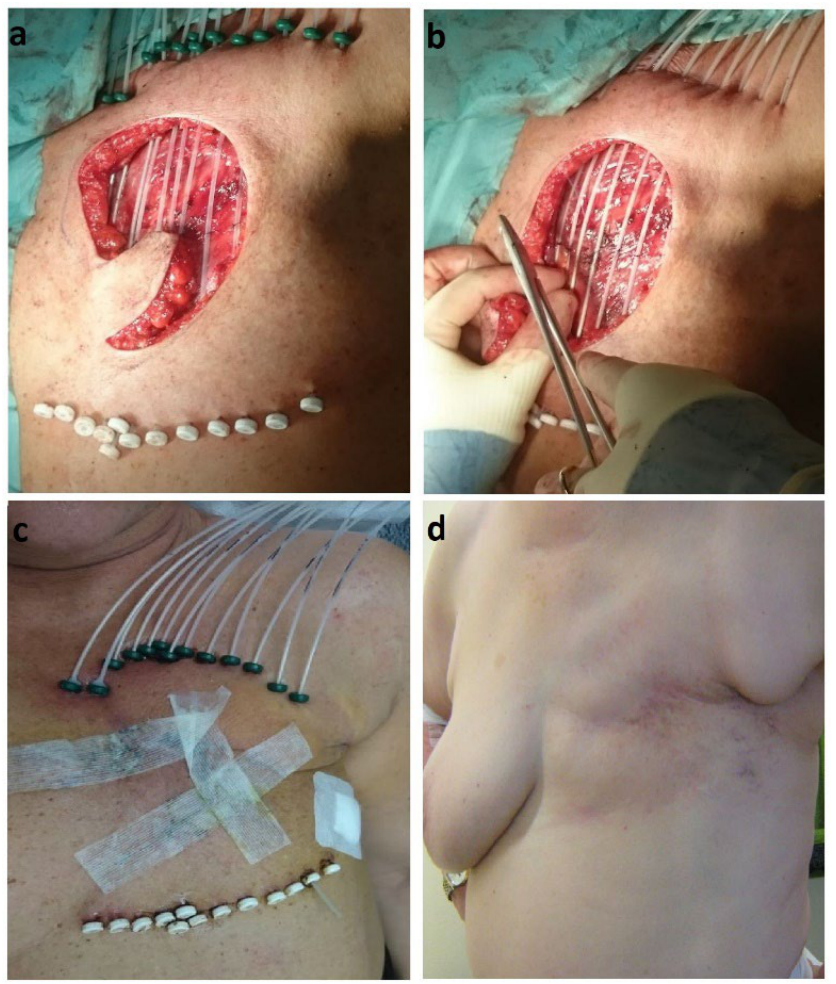
Figure 1. ( a ) and ( b ): intraoperative catheter implantation and suturing; ( c ): during the irradiation; ( d ): 5 years after high-dose-rate interventional radiotherapy. Thin-slice computed tomography (CT) was performed on the second or the third postoperative day and digitally forwarded into the treatment planning system (TPS). The three-dimensional (3D) reconstruction of the CT images was used for tubes reconstruction, volume definition, and dose planning/optimization on the TPS (Oncentra planning; Elekta Brachytherapy, Veenendaal, Netherlands). The clinical target volume (CTV) included the estimated tumor bed, the surgical clips, and a safety margin of 10–20 mm according to